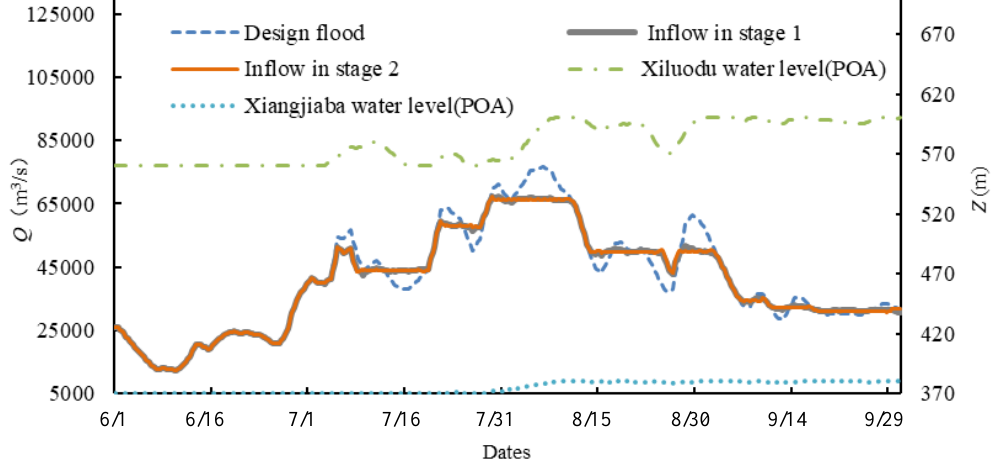
Figure 6. Design flood hydrograph of the year 1954, inflow of TGR and water levels of the Xiluodu and Xiangjiaba Dams.